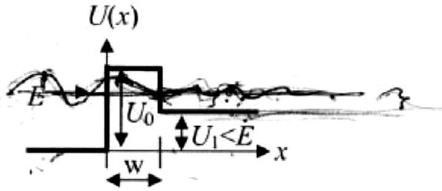
FIG. 8. A student drawing of a wave function on top of a potential-energy graph.